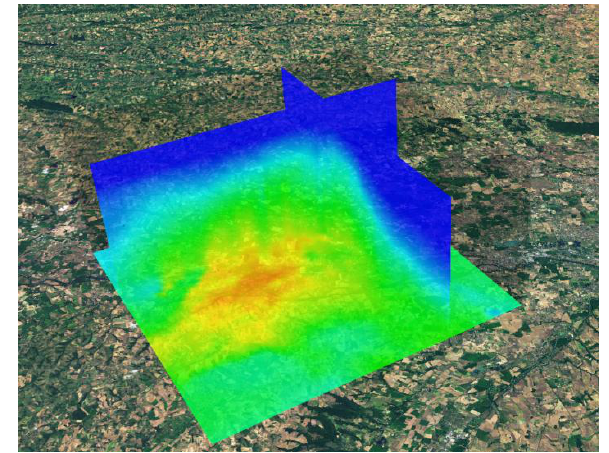
Figure 10 – Rendering of slice planes of volume